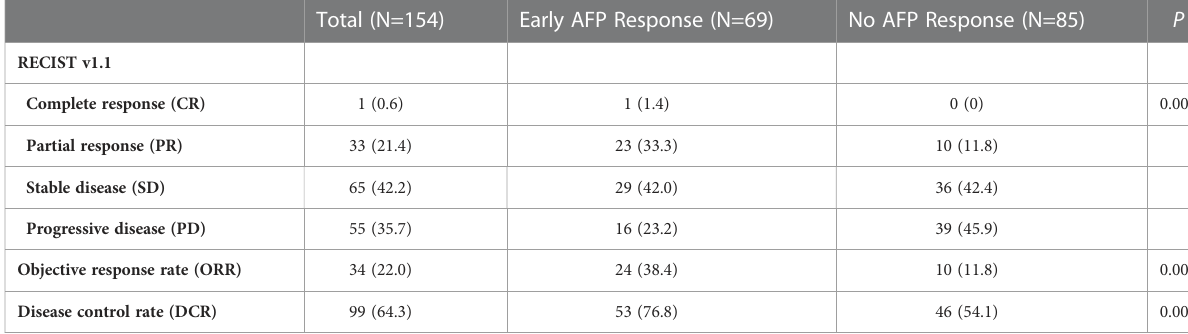
TABLE 2 Comparison of the ef fi cacy between the patients with and without early AFP response.